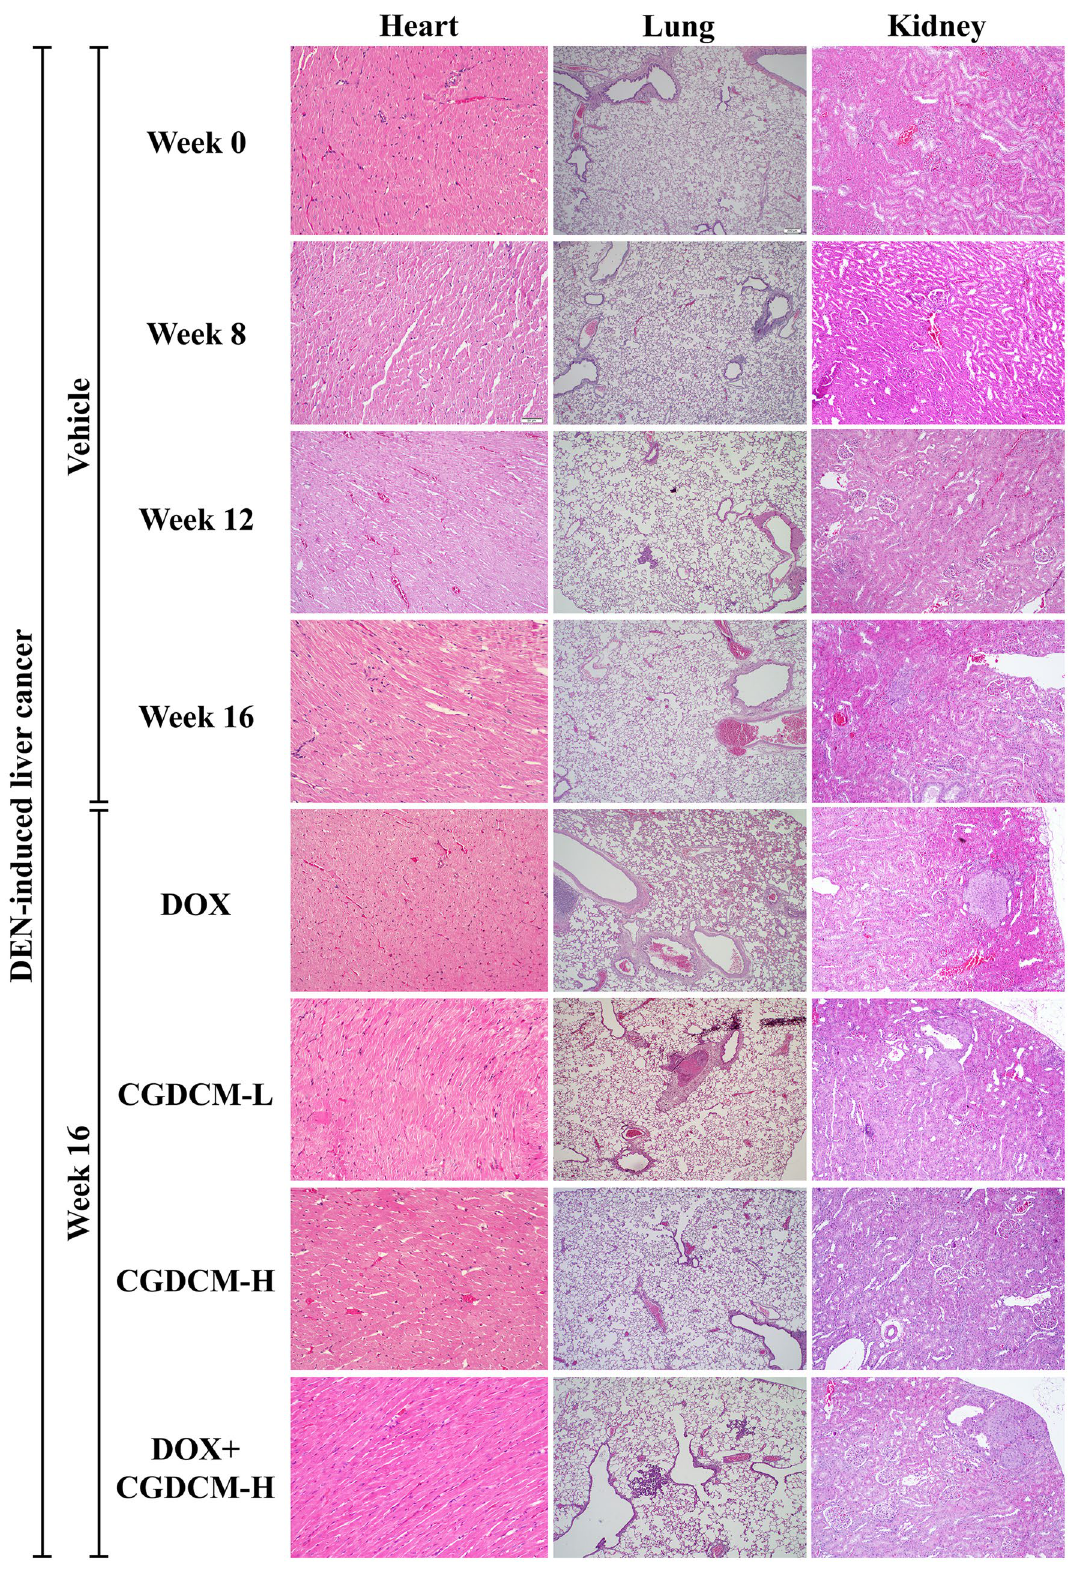
Figure 13. The toxicity in rat tissues in DEN-induced liver cancer rats. Representative histopathological sections of rat tissues were stained with H&E in DEN-induced liver cancer rats for 8 weeks, and the treatments were performed for 4 weeks from week 12, which included DOX, CGDCM-L, CGDCM-H, and the combination of DOX with CGDCM-H extracts from stem bark of C. gigantea . The vehicle group was treated with 0.8% DMSO. Scale bars = 200 μm, 100 µm, and 50 µm under × 4, × 10, and × 20 magnification. CGDCM , C. gigantea dichloromethane extract; CGDCM-L, CGDCM low dose; CGDCM-H, CGDCM high dose; DOX,